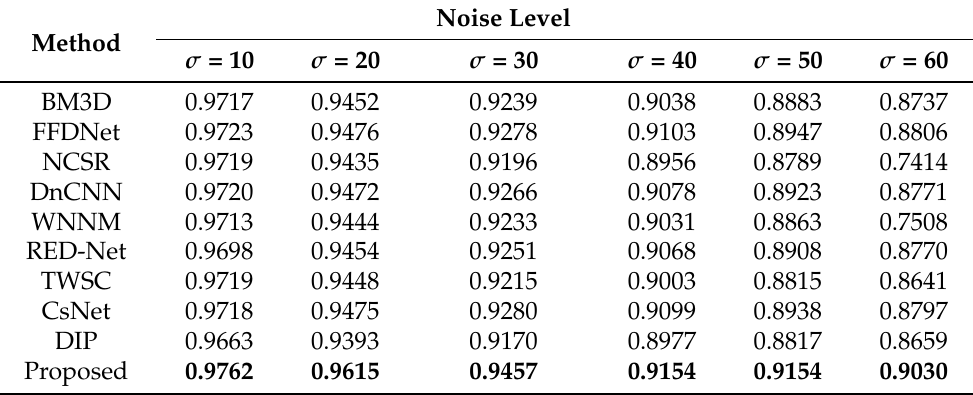
Table 8. Average FSIM results of different methods on 10 commonly used images with various noise